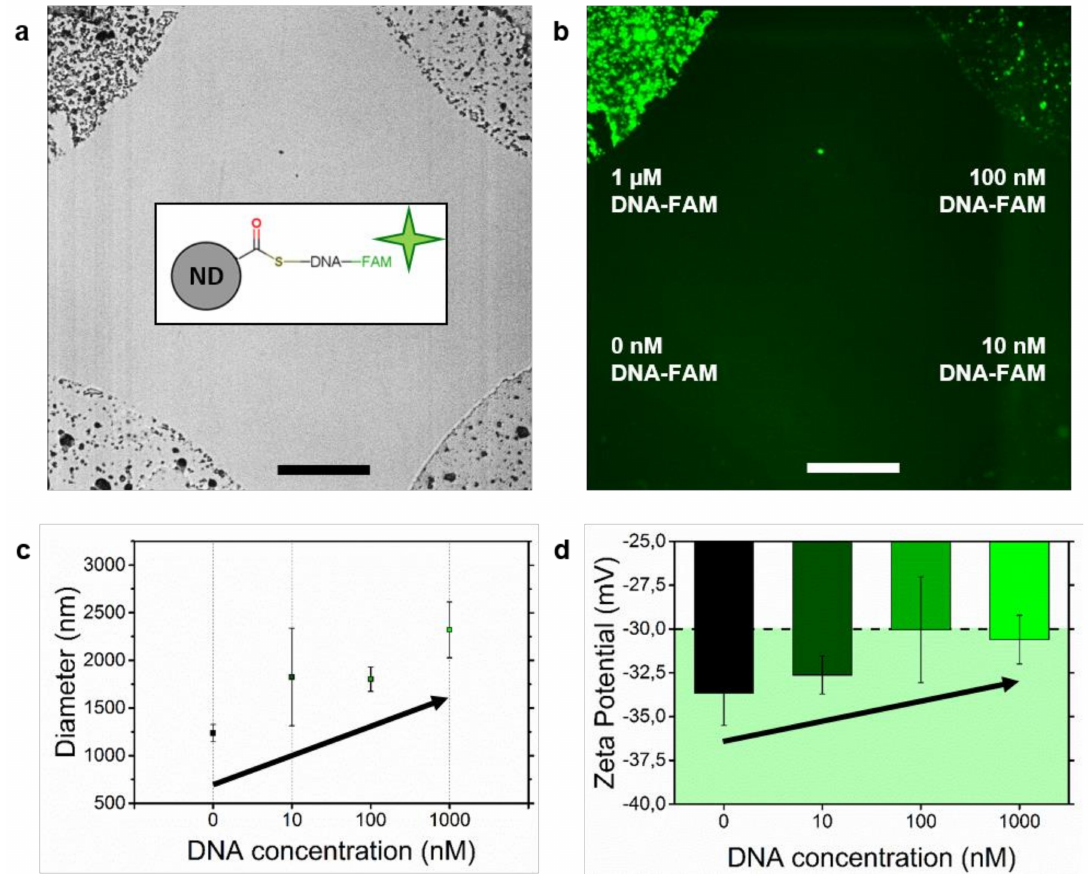
Figure 4. ( a ) Optical bright-field microscopy image and ( b ) correlated fluorescent microscopy image of fluorescently labelled ssDNA grafted onto NDs. Scale bar = 50 µ m. ( c ) Dynamic light scattering and ( d ) zeta potential measurements of ND/ssDNA conjugates in phosphate-buffered saline (PBS). Concentration of ssDNA range from 0–1000